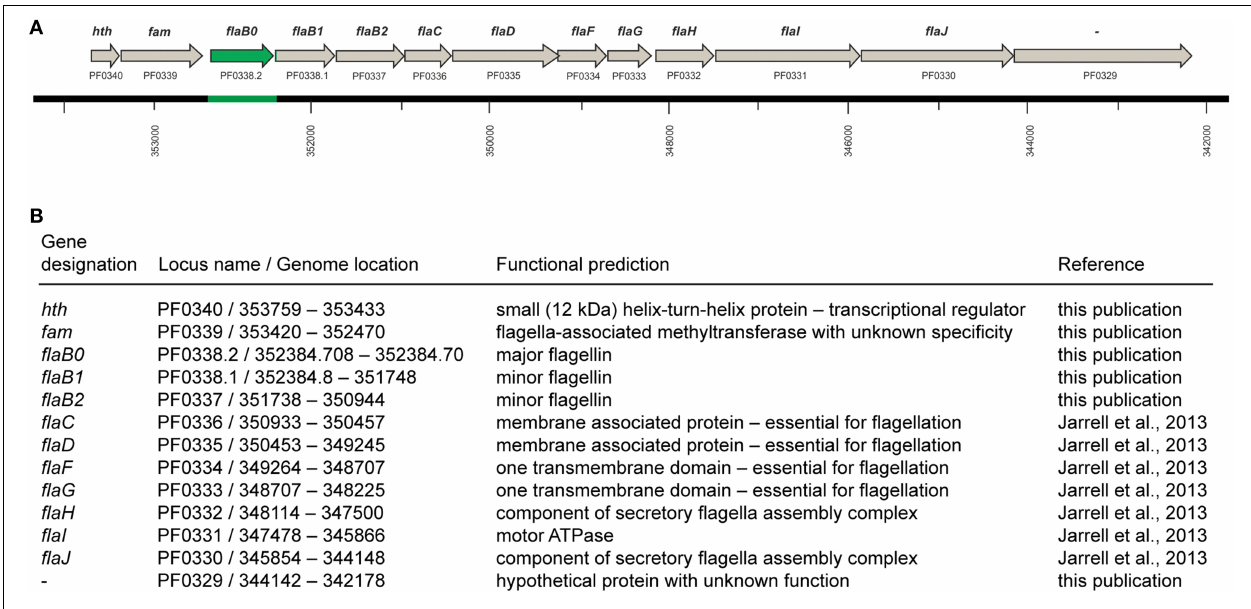
FIGURE 1 | The flagellar operon of Pyrococcus furiosus . (A) The revised flagellar operon with neighboring genes. The missing genomic sequence and the flaB0 gene are marked in green. All genes are